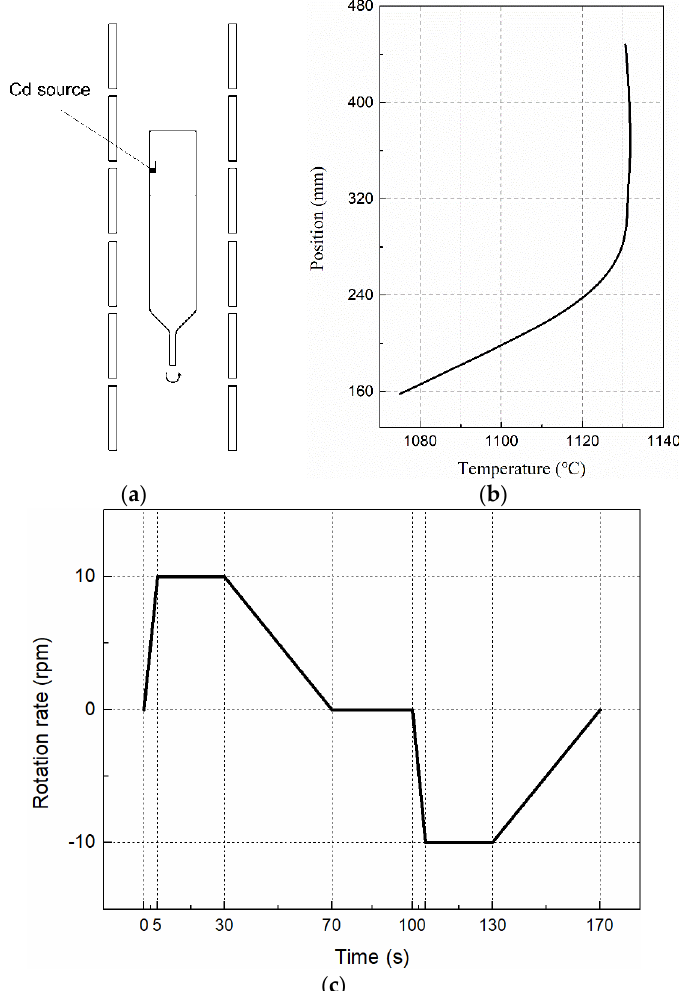
Figure 1. ( a ) Ampoule with an additional Cd source, ( b ) axial distribution of the temperature field, and ( c ) accelerated crucible rotation technique (ACRT) sequence used during the growth process.